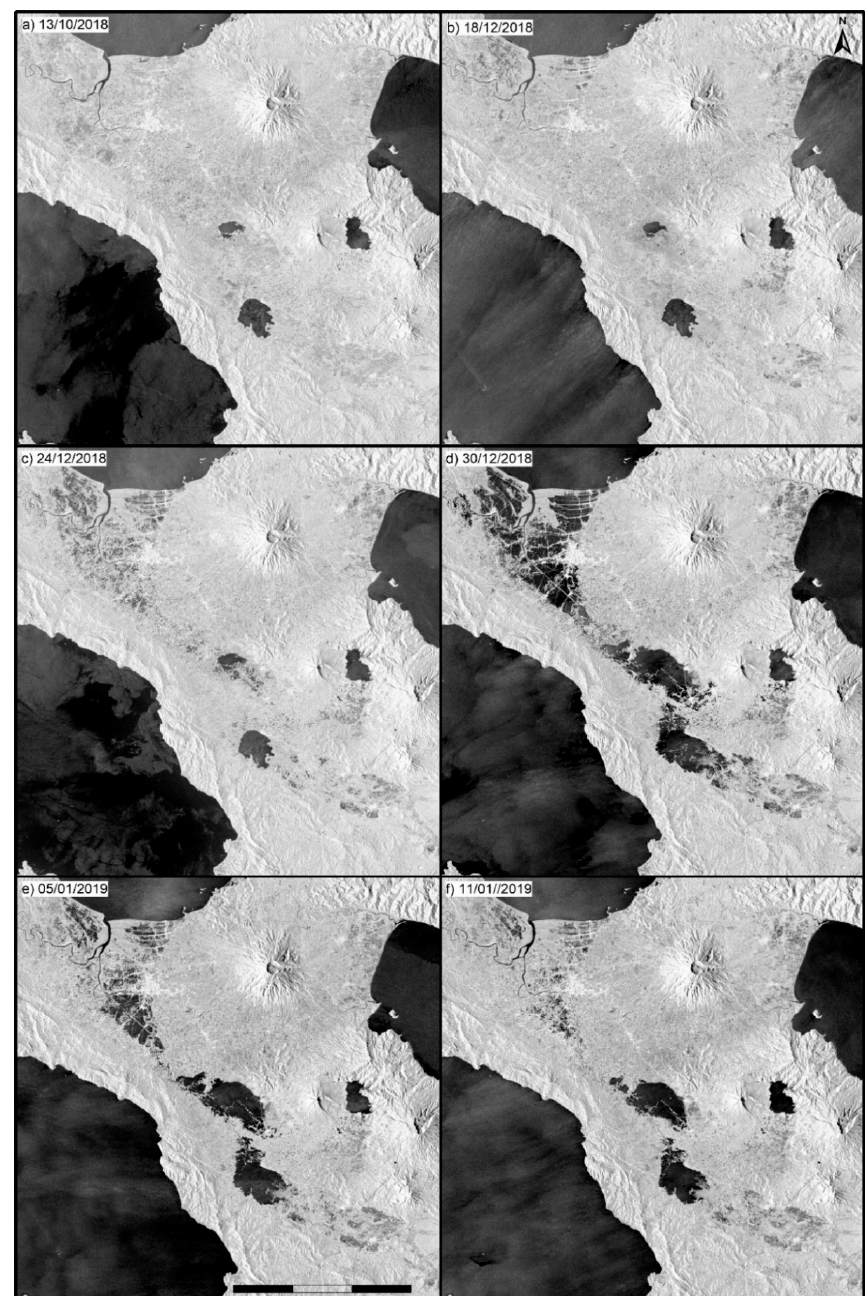
Figure 2. Examples of pre-processed Synthetic Aperture Radar (SAR) images of the study area in the period between 13 October 2018, and 11 January 2019. The dark areas represent open water features and shadow zones.